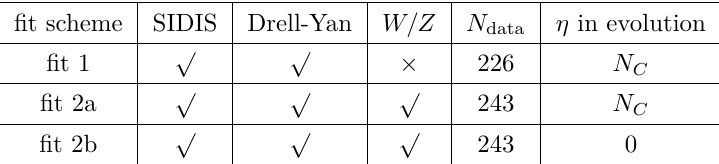
Figure 7 . The extracted transverse moment of the Sivers function from fit 1 at µ 0 = The black curve is the fit to the experimental data with no Gaussian